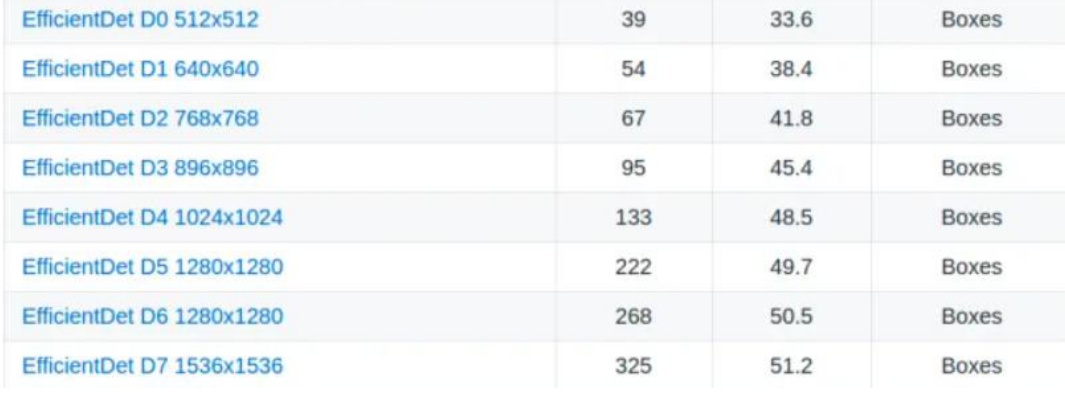
Figure 18. EfficientDet Network Models.